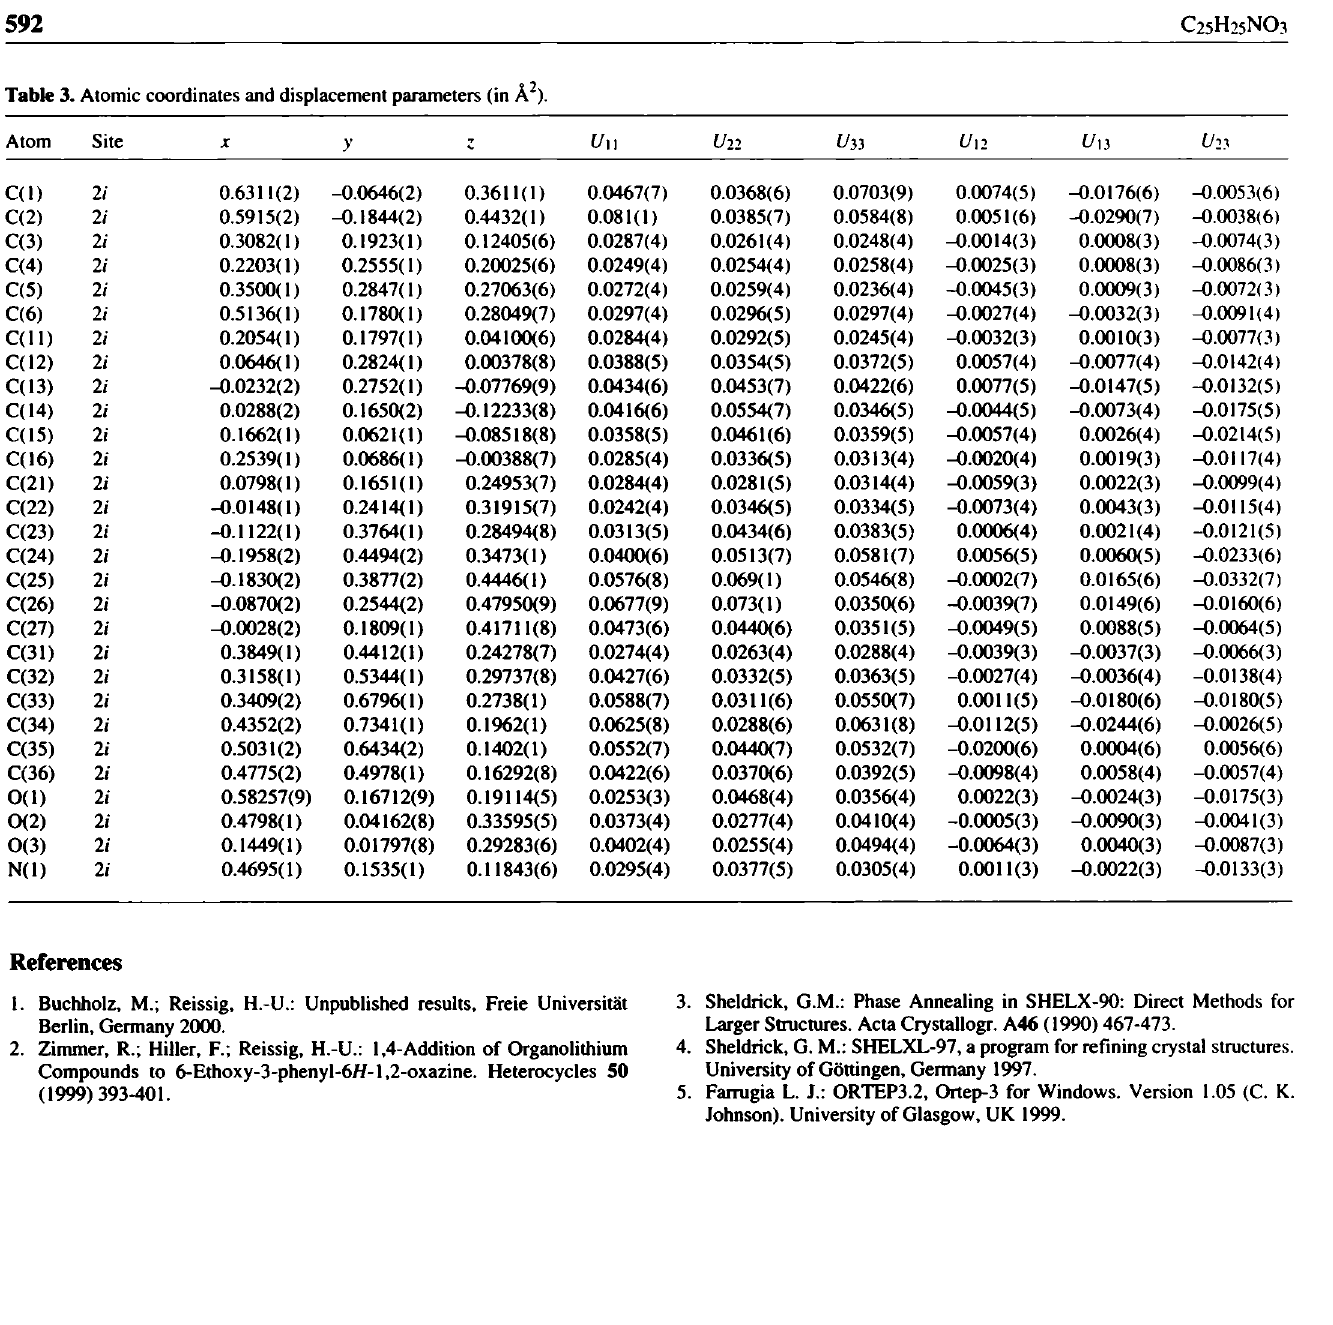
Table 3. Atomic coordinates and displacement parameters (in Ä 2